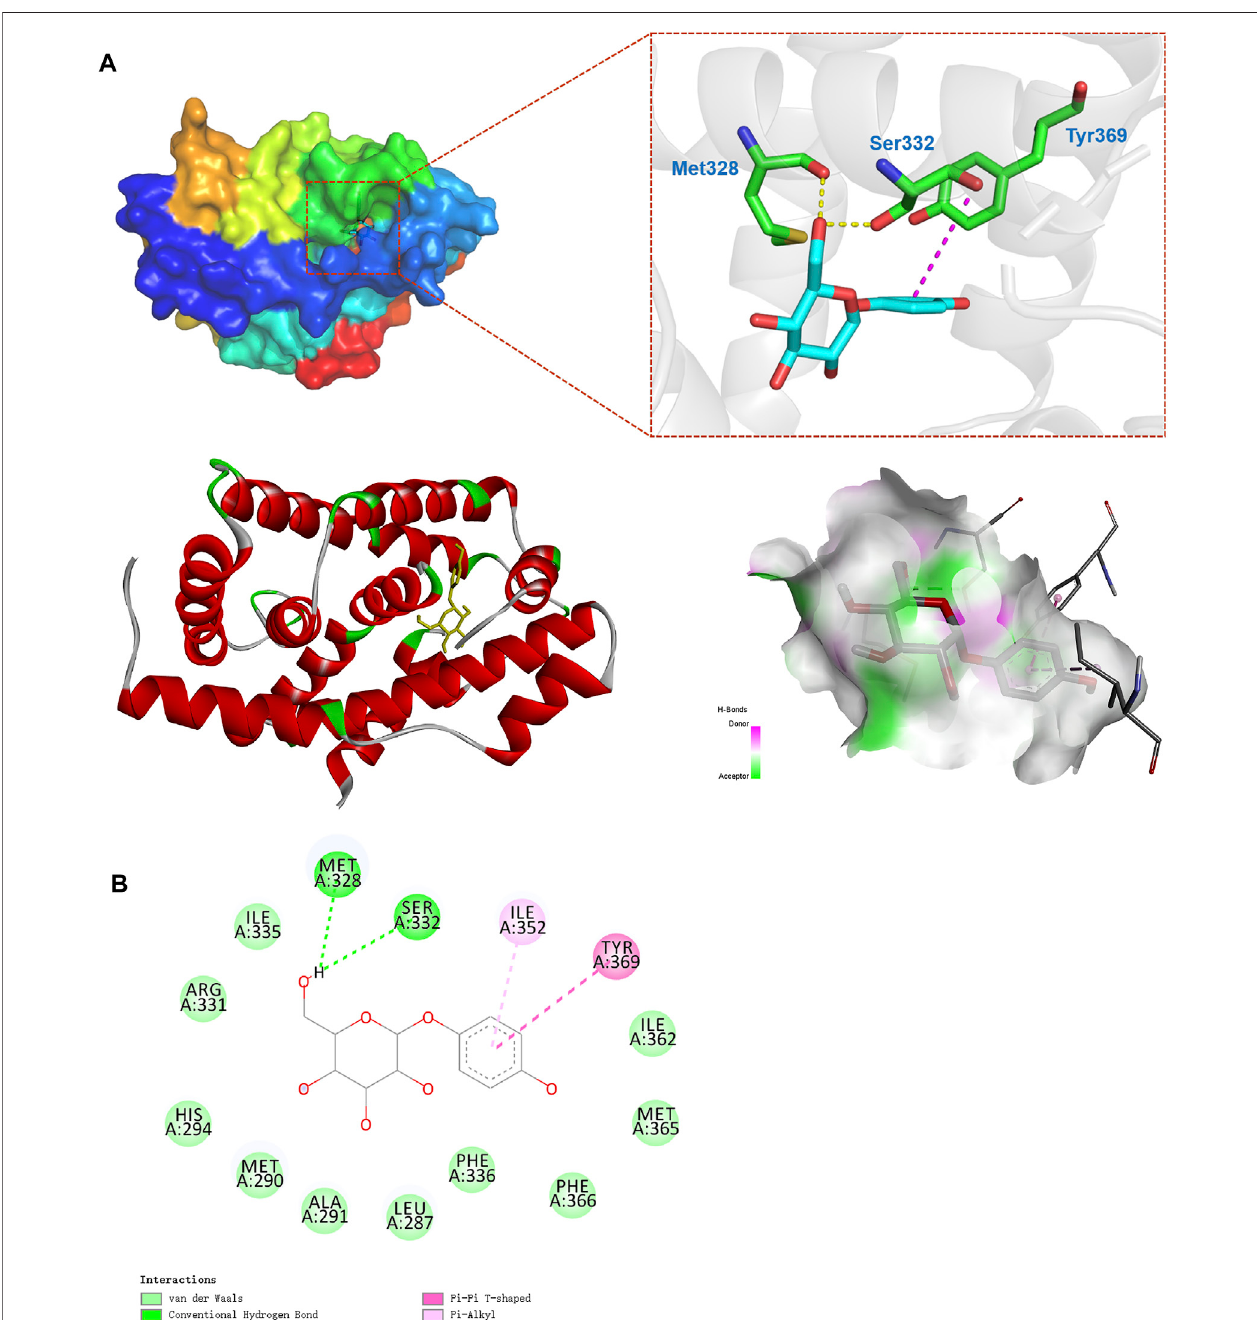
FIGURE6| OptimizedbindinganalysiswithFXRandarbutin. (A) The3DbindingmodesbetweentheFXR(PDBcode:4QE6)andarbutin.Electrostaticpotentialon the FXR molecular surface around the binding site of arbutin and interactions between arbutin and main amino acids in the active site. Hydrogen bonds are shown as dotted lines; (B) 2D binding pattern diagram between arbutin and FXR.